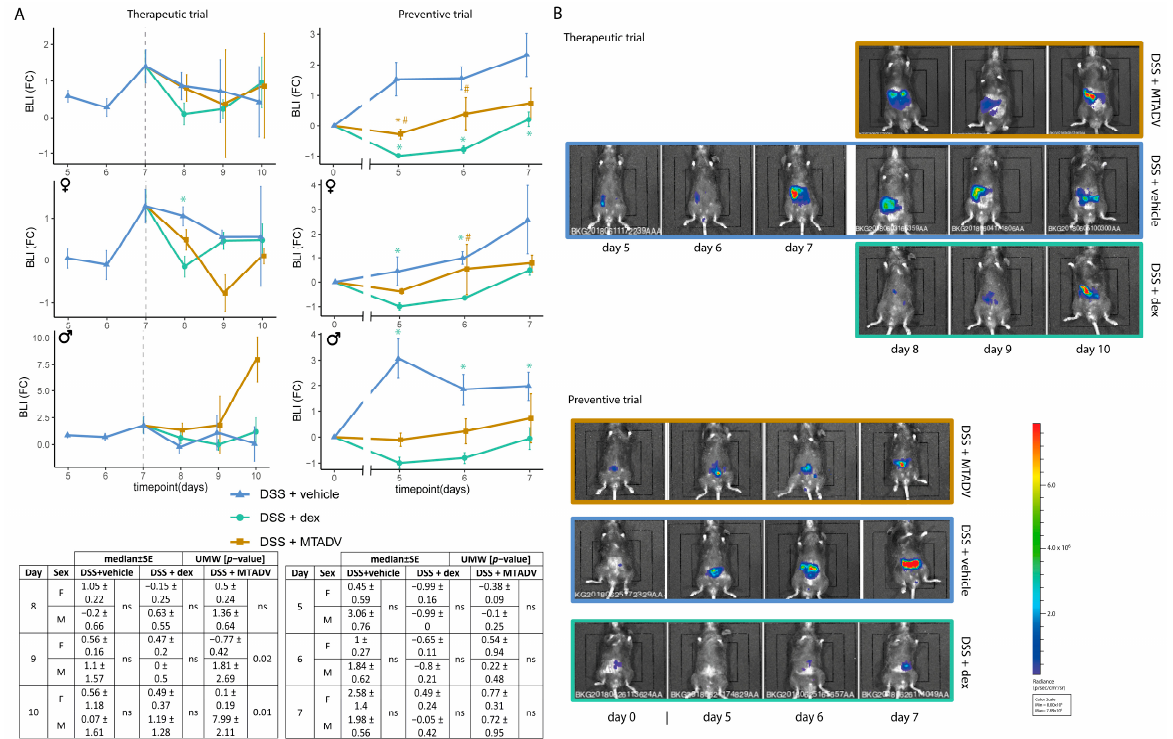
Figure 2. Bioluminescence evaluations in the follow-up of the DSS model. ( A ) BLI is represented as median FC ± SE in the follow-up, represents therapeutic and preventive approaches, and is stratified by sex. Colors and dots denote treatment groups. Tables showing the statistical test (UMW) between sexes at each time point are given. ( B ) Graphical representation of bioluminescent images of each trial and treatment at each time point. Blue color represents the minimum pixel level, and red color the maximum pixel density. Asterisks indicate differences between treatments and vehicle admin- istration, whereas pads mark differences between dexamethasone and MTADV treatments at each time point (Kruskal–Wallis with posthoc Dunn’s test). Significance levels: */ # 0.01 ≤ p ‐ value ≤ 0.05. BLI, bioluminescence intensity; dex, dexamethasone; DSS, dextran sulfate sodium; F, female; FC, fold ‐ change; M, male; MTADV, 5 ‐ MER peptide methionine ‐ threonine ‐ alanine ‐ aspartic acid ‐ valine; SE, standard error; UMW, U Mann–Whitney test.